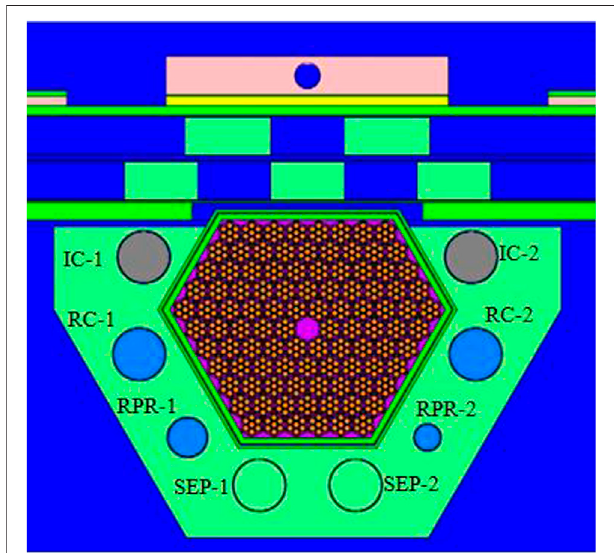
FIGURE 3 | Design scheme of FPPRU2.